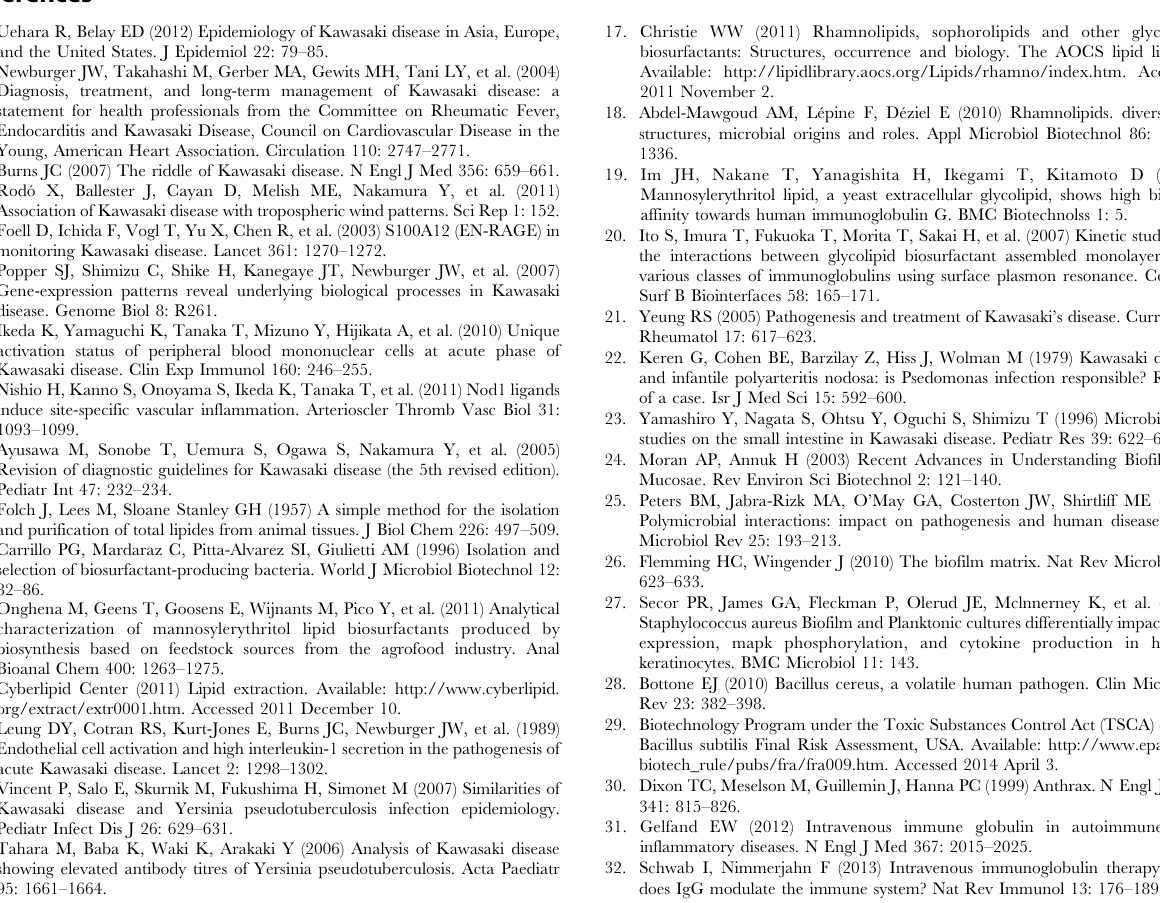
study. Table S5, Sequences of oligonucleotide primers used for the amplification microbial